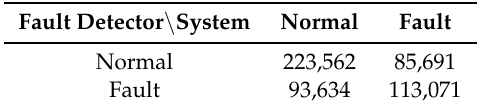
Table 8. Confusion matrix for fault detection, based on Hammerstein-Wiener model and an adaptive threshold.